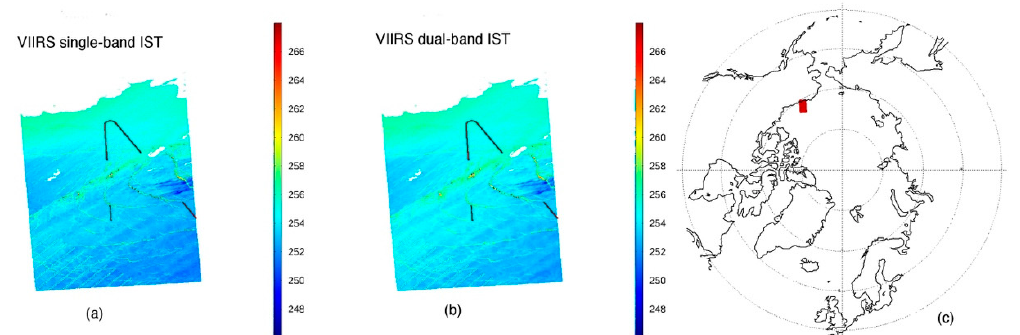
Figure 5. VIIRS IST with the single-band approach using the I-5 band ( a ) and with the M-band dual-band approach ( b ), with the IceBridge flight shown (red line) around 22:17 UTC on 30 March 2015 off the North coast of Alaska ( c ). The white color in IST field represents cloud cover in the M-band cloud mask.